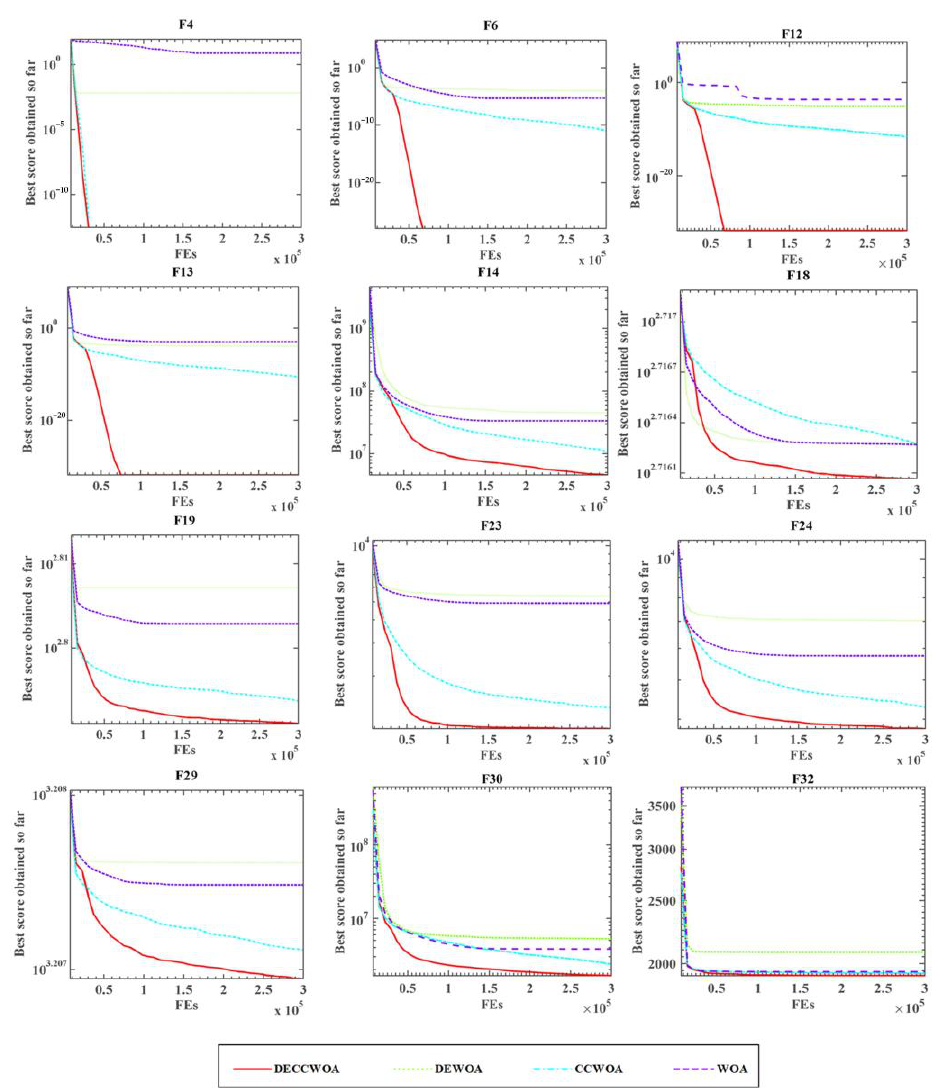
Figure 4. Convergence curves of the comparison results for the introduced mechanisms.